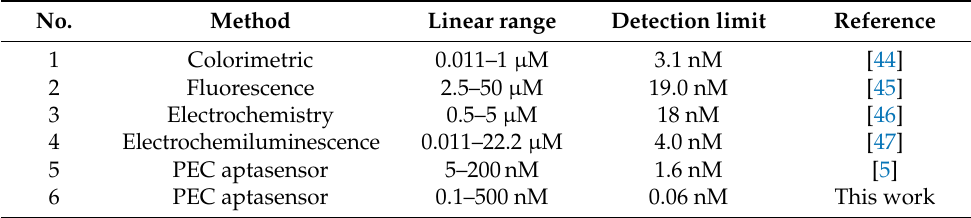
Table 1. Various methods for TC determination.